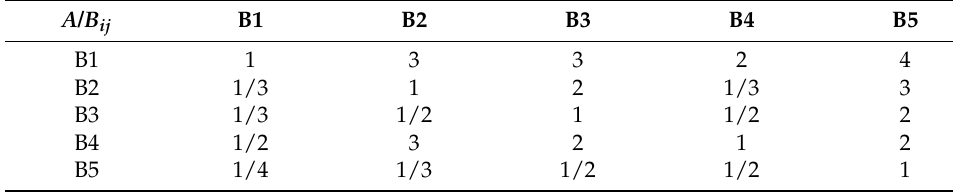
Table 5. The judgment matrix for A and B.